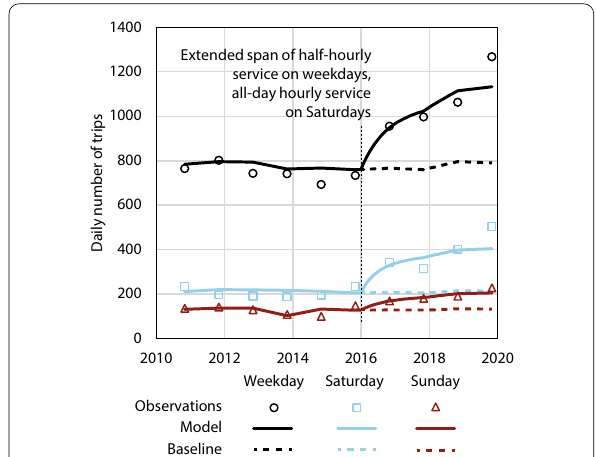
Fig. 7 Patronage development in case D, the bus service between Trelleborg and Ystad, showing annual autumn measurements and model estimations of the patronage development with and without off‑peak service improvements (the latter corresponds to the counterfactual baseline